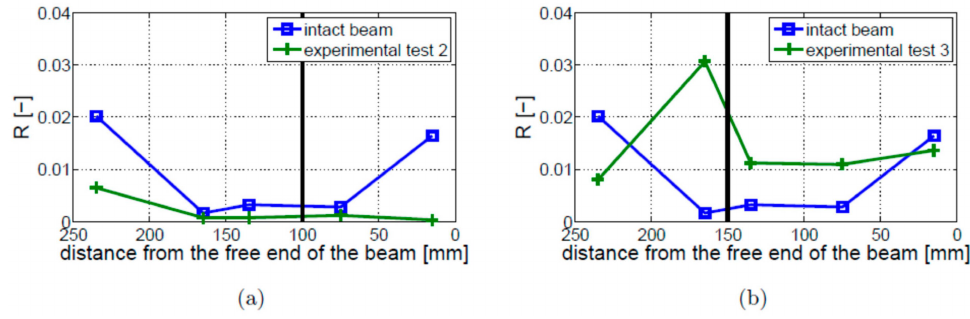
Figure 22. Values of R coefficient for the fixed–free boundary conditions: ( a ) Experimental Test 2; ( b ) Experimental Test 3. Both results are compared with the intact beam results. The crack location is indicated by the vertical solid black